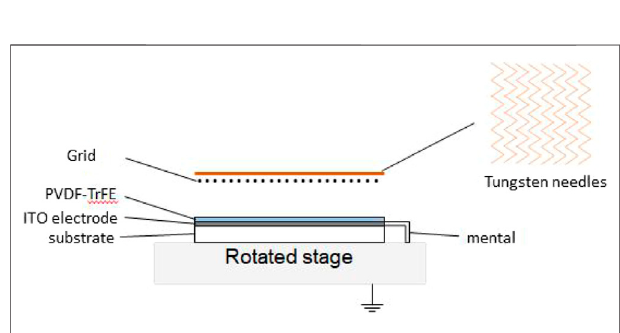
FIGURE 3 | Schematic diagram of in situ polarization.